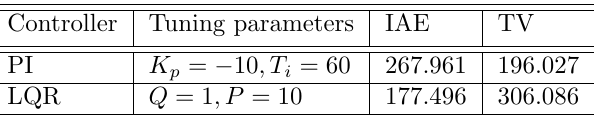
Table 1: Comparing PI vs LQR control strategy using measures: Integrated Absolute Error (IAE) and Total Value (TV). See Fig. 17